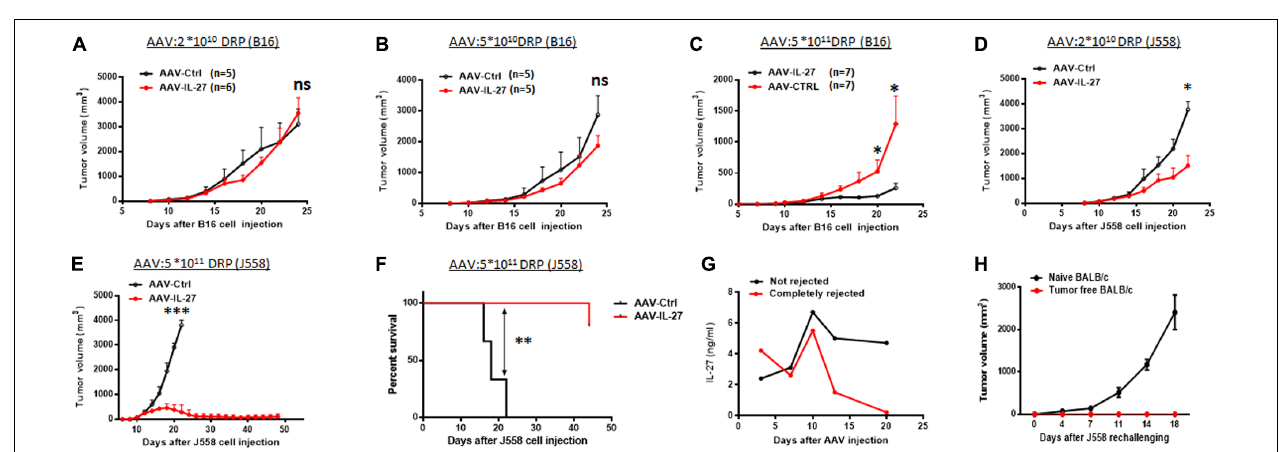
FIGURE 2 | Intra-tumoral injection of AAV-IL-27 inhibits tumor growth and stimulates protective immunity in mice. (A–C) B16.F10 cells (2 × 10 5 cells) were injected into C57BL/6 mice s.c. 7 days later, AAV-IL-27 or AAV-ctrl virus were directly injected into the established tumors at the indicated dose. (D–F) J558 cells (5 × 10 6 cells) were injected into BALB/c mice s.c. Five days later, mice were treated with AAV-IL-27 or AAV-ctrl virus intra-tumorally at the indicated doses. Tumor volume changes (A–E) and mice survival (F) were recorded. (G) Serum IL-27 concentrations in mice with J558 tumors or mice whose tumors were rejected. (H) J558 cells were injected into mice whose tumors were rejected after AAV-IL-27 therapy or naïve BALB/c mice, and tumor growth was compared. Data shown represent 2–3 experiments with similar results. ns: no significant difference. * P < 0.05, ** P < 0.01, *** P < 0.001by One-way ANOVA or Log-rank